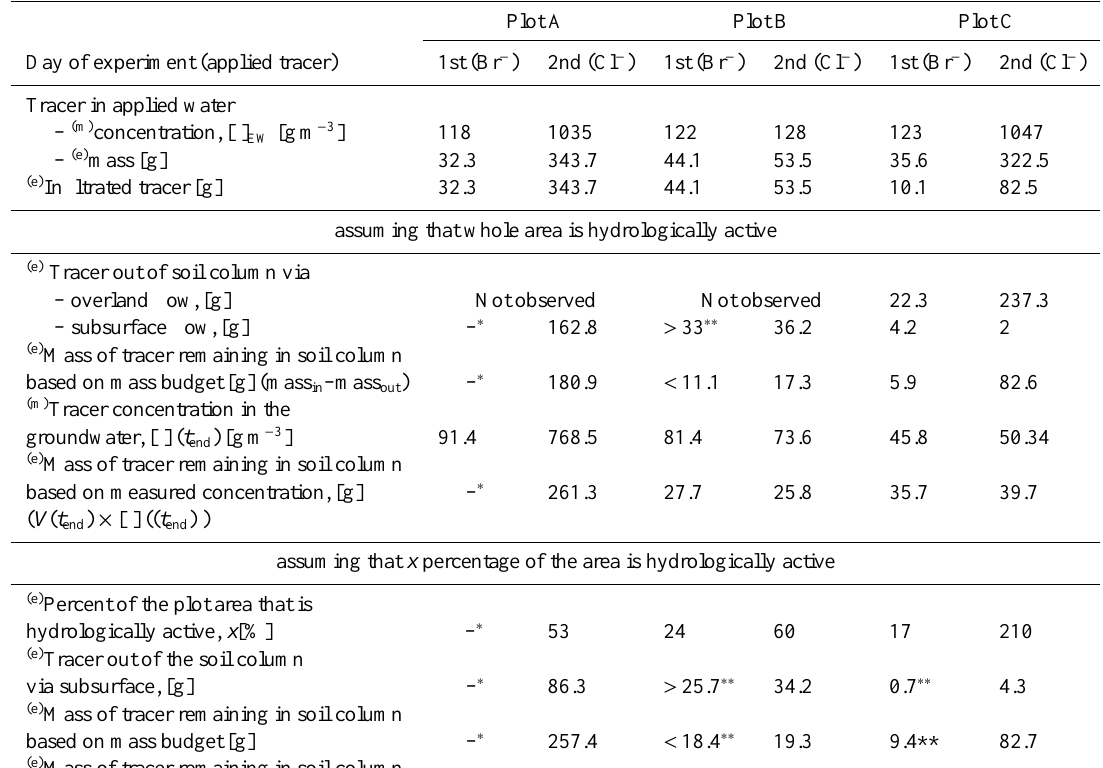
Table 2. Measured ( m ) and estimated ( e ) tracer mass balance components and the evaluation of the hydrologically active area assumptions. Plot A Plot B Plot C Day of experiment (applied tracer) 1st (Br − ) 2nd (Cl −